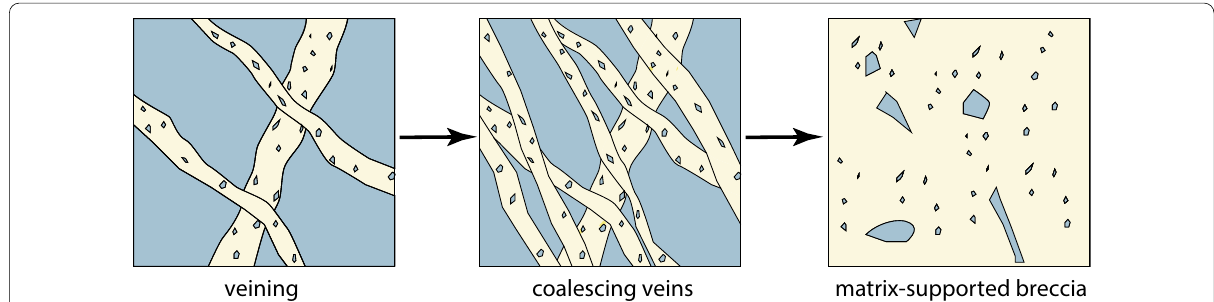
Fig. 24 Fragmentation process: from veining to coalescing veins and comminuted limestone with angular fragments of shattered